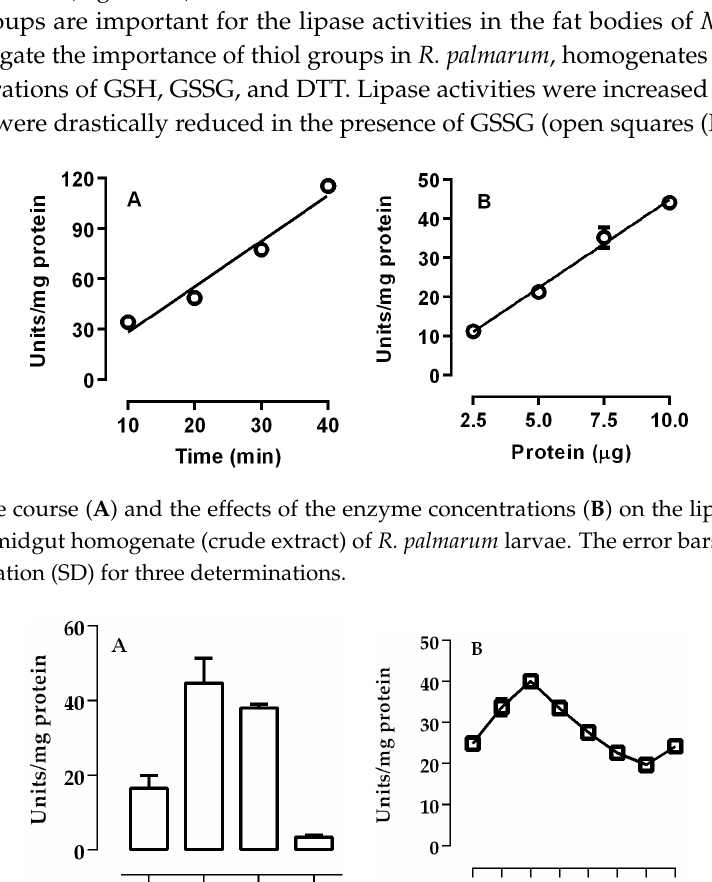
Figure 2. The optimum temperature ( A ) and optimum pH ( B ) for lipase activity of the posterior midgut homogenate (crude extract) of R. palmarum larvae. The error bars represent the SD for the three determinations.